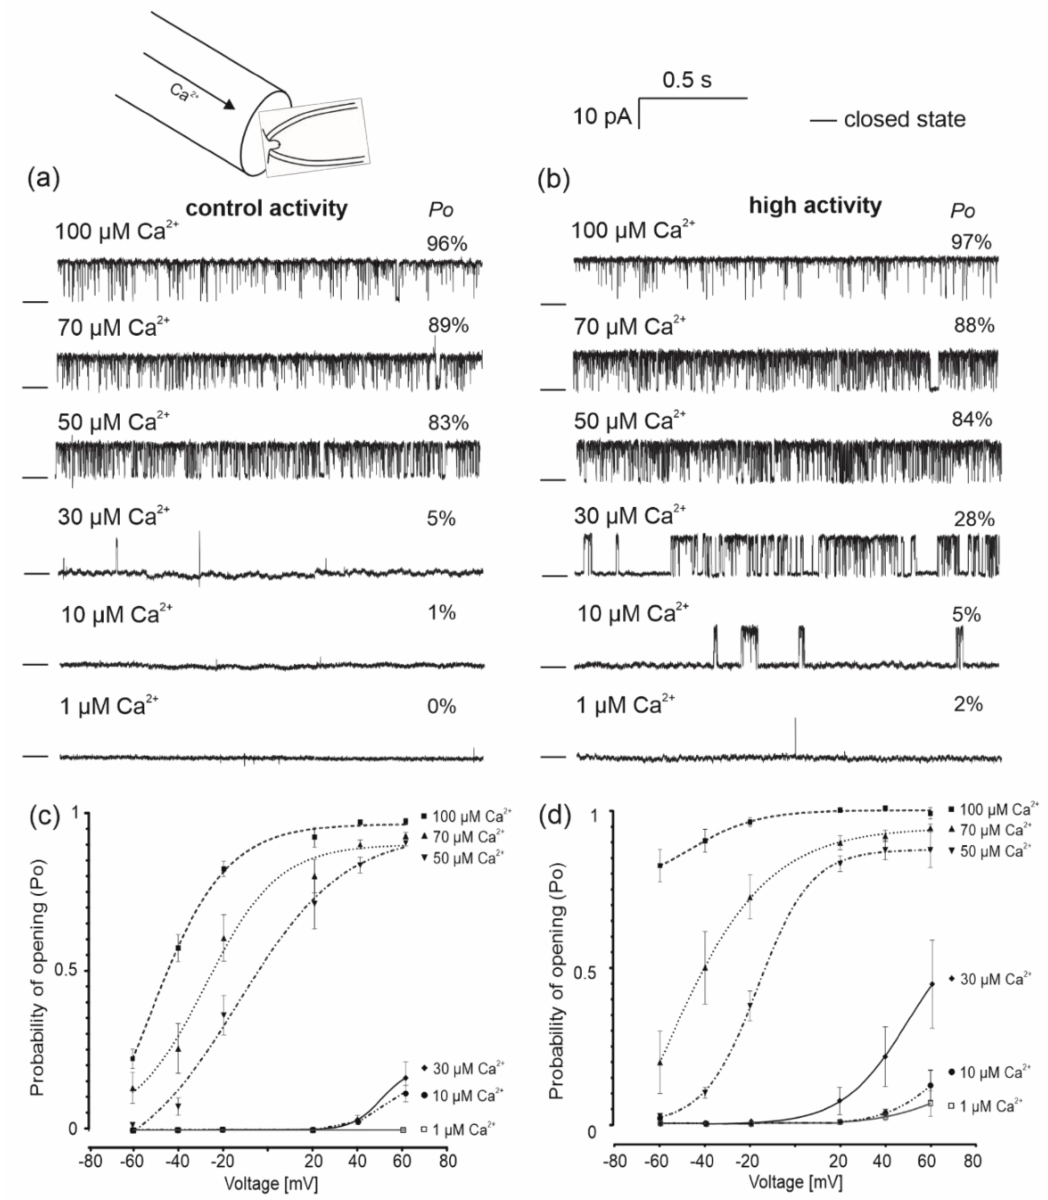
Figure 3. Regulation of the two populations of mitoBK Ca channels by calcium ions. ( a , b ) Representative single-channel current-time recordings of the mitoBK Ca channel in the presence of different calcium concentrations (1, 10, 30, 50, 70 and 100 µ M Ca 2+ ). Both types of channel activities recorded in 150/150 mM KCl isotonic solution at +40 mV are presented ( n = 3). “—” indicates a closed channel state. “ Po ” represents the average channel open probability. ( c , d ) Quantification of the open probability of channels in the presence of 100, 70, 50, 30, 10 and 1 µ M Ca 2+ . Data are presented as the means ± SD ( n =